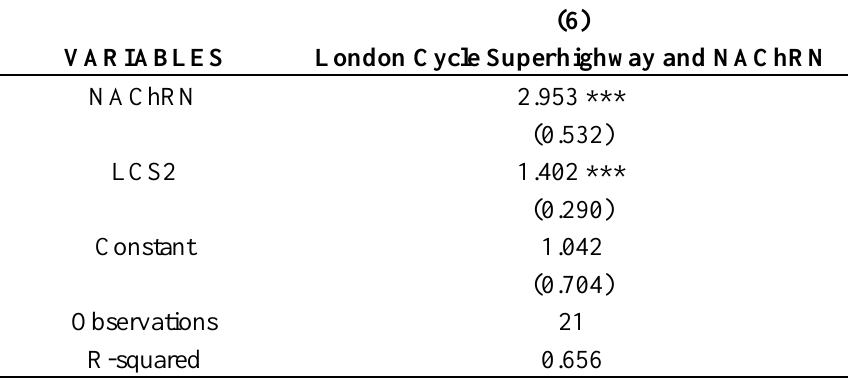
Table 7. Cyclist movement model regression